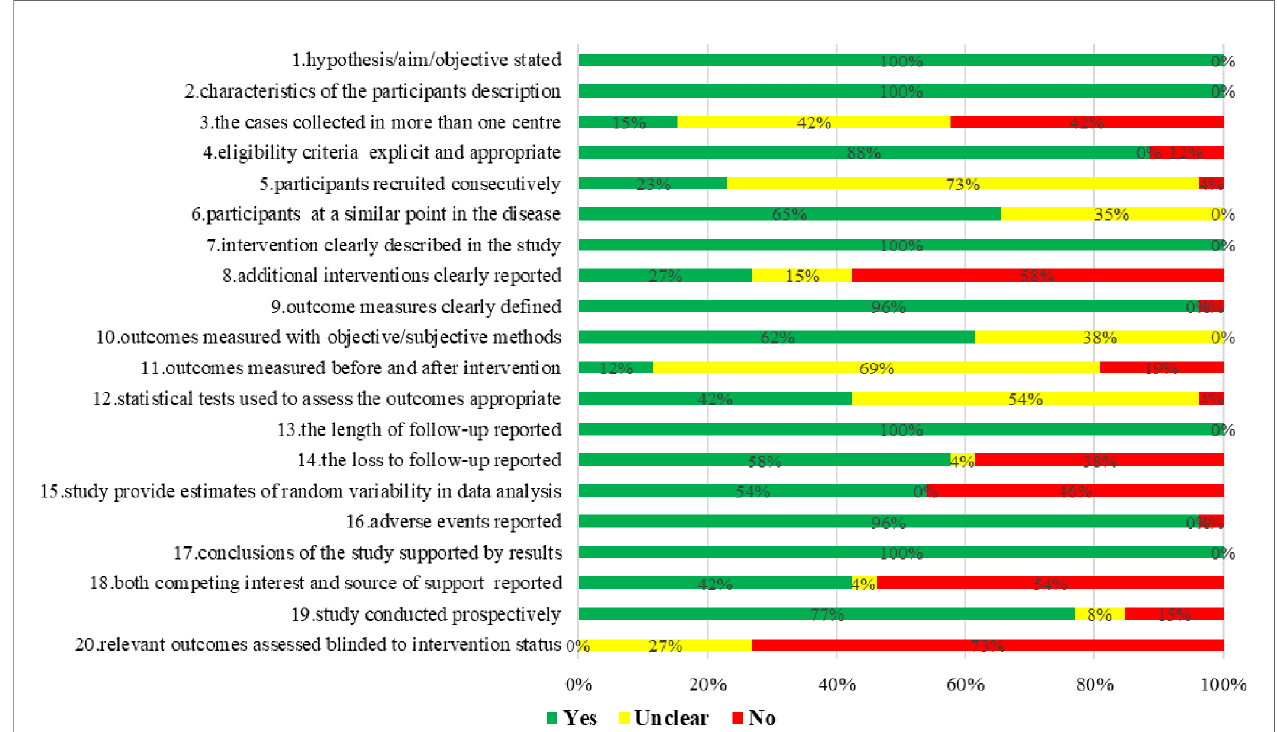
FIGURE 2 | Risk of bias assessment of case series studies of proton and carbon ion radiotherapy for prostate